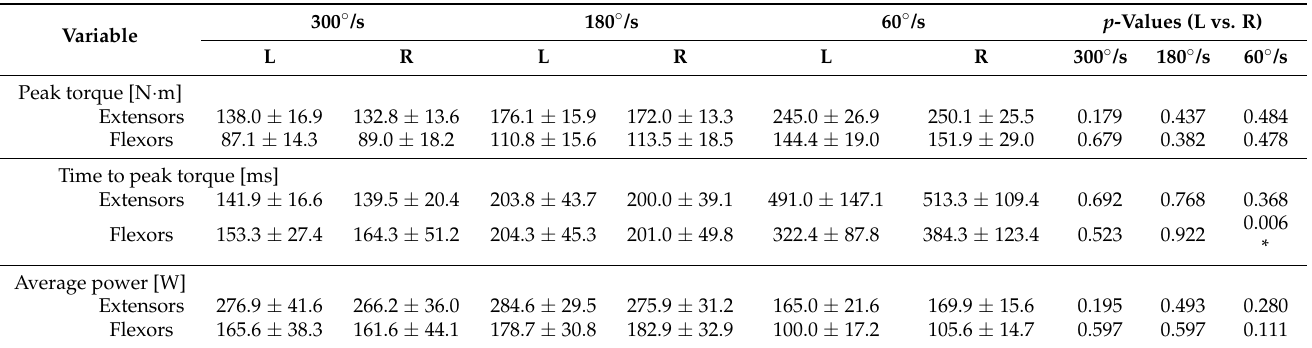
Table 1. Mean ± standard deviation of the peak torque, time to peak torque, and average power as well as statistical test p -values.